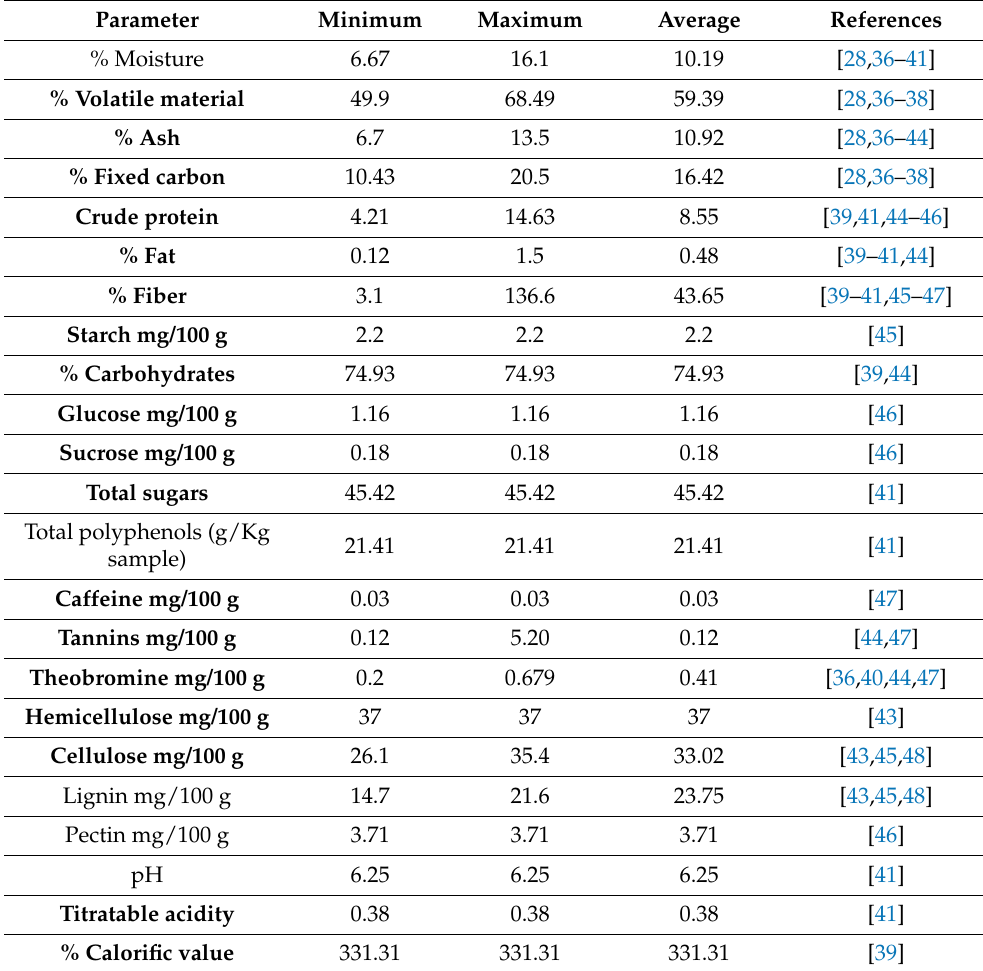
Table 1. Reports of physicochemical characterization of